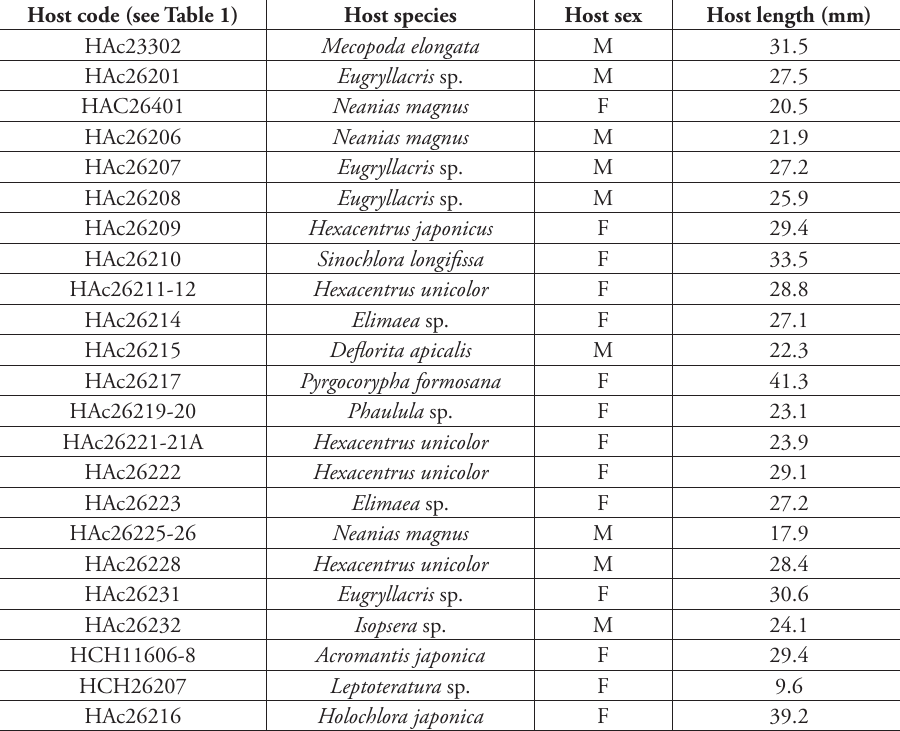
Table 2. Mantid and grasshopper horsehair worm host information. Host code (see Table